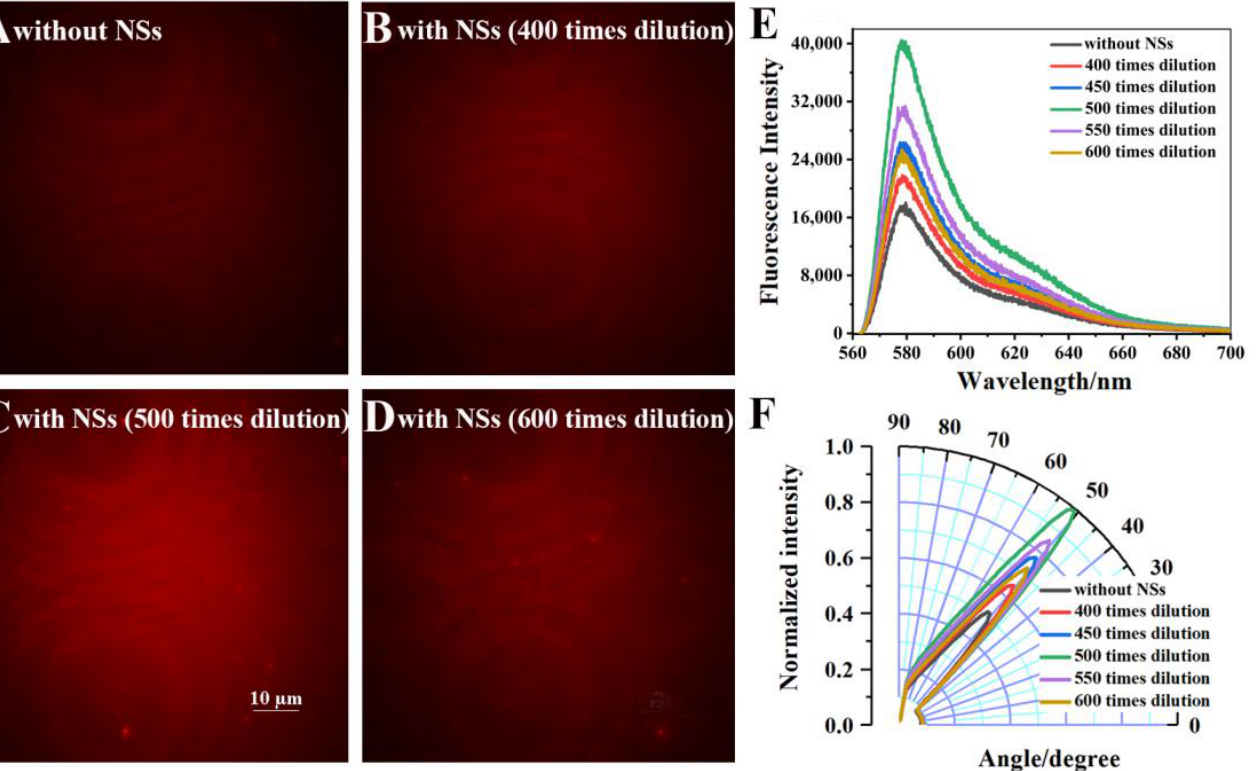
Figure 3. Images of the RhB-PMMA fluorophore layer ( A ) without Au-Ag NS and with different concentrations of Au-Ag NS [( B ) 400 times, ( C ) 500 times, and ( D ) 600 times dilution]. ( E ) The fluo- rescence spectrum and ( F ) excitation angular distribution for RhB-PMMA fluorophore layer with different concentrations of Au-Ag NS.